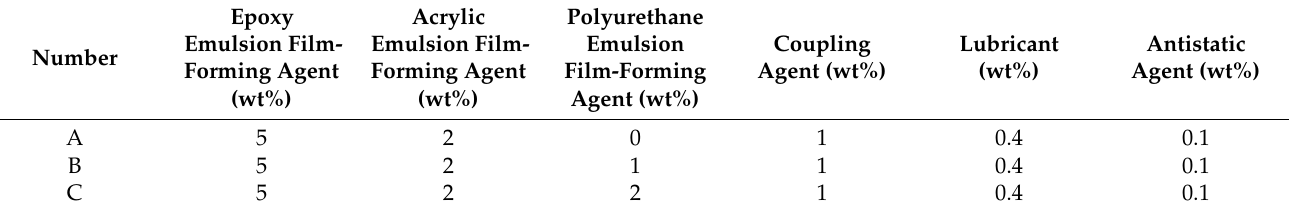
Table 1. Proportion of each component of sizing